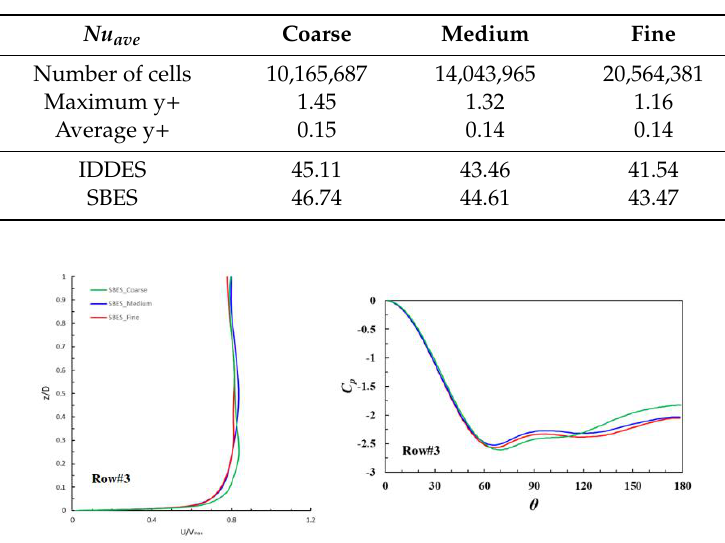
Figure 3. Time-averaged streamwise velocity profile and pressure coefficient at row 3 of each grid in the stress-blended eddy simulation model.